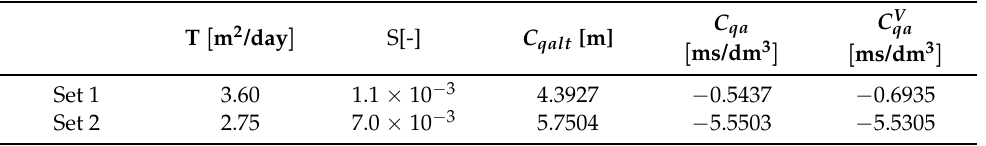
Table 3. Calibrated parameters, T and S , for the reference model; and constants for the simplified model, C qa and C qalt . The value C V qa corresponds to a recalibrated value during validation. T [ m 2 /day